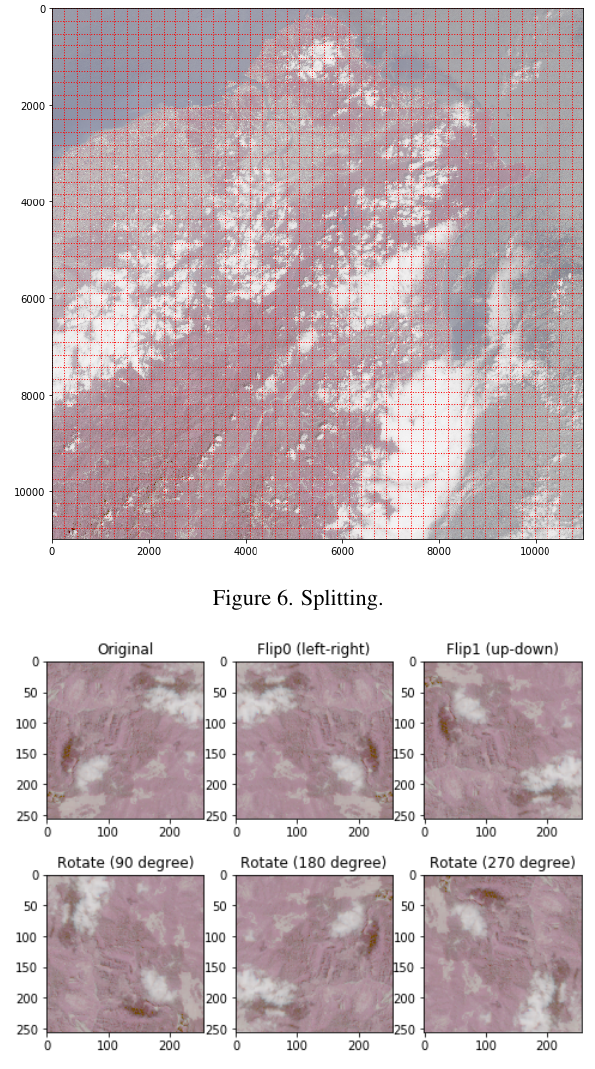
Figure 7. Augmentation.